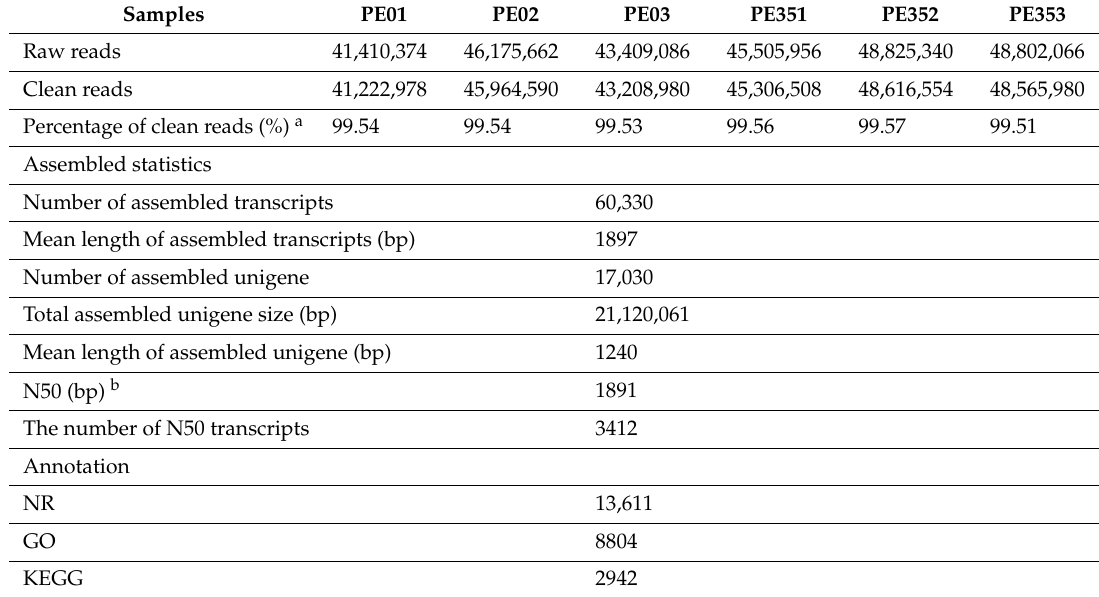
Table 2. Assembly and annotation statistics of P. tuoliensis mycelia